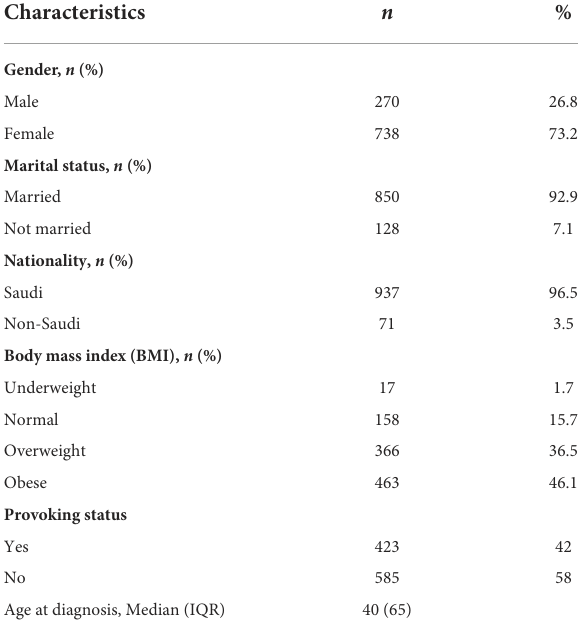
TABLE 1 Demographic characteristics of the study participants.